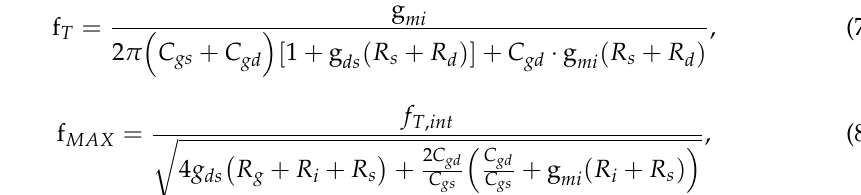
where g mi is the intrinsic transconductance, C gs and C gd are the parasitic capacitances from gate to source and gate to drain, respectively; g ds is conductance between drain and